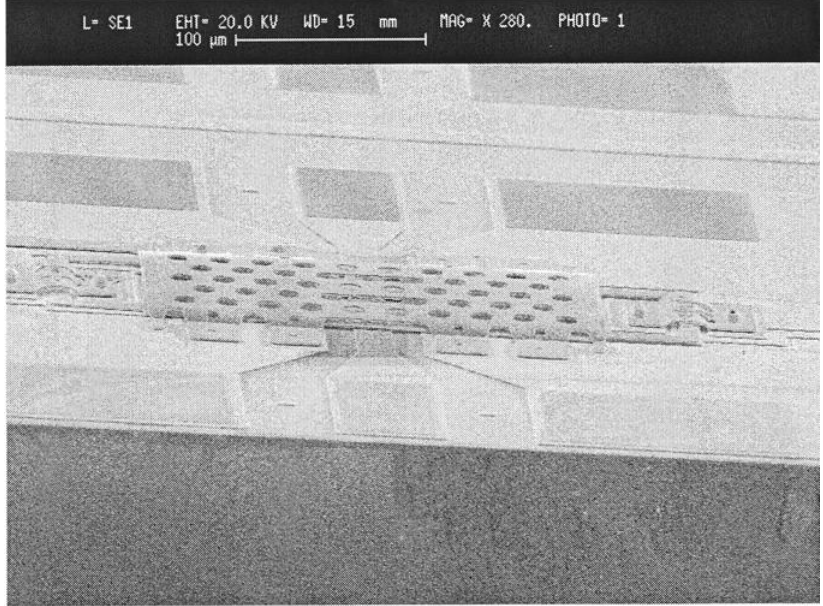
FIGURE 10 A SEM photograph of a fabricated hinged